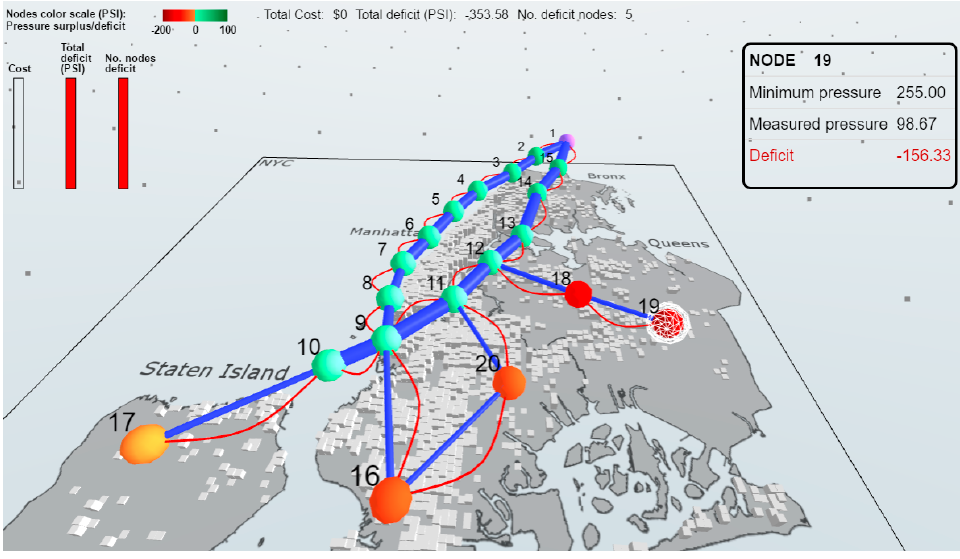
Figure 1. The SeGWADE 3D interface showing the network and an information box (showing deficient pressure at a node).